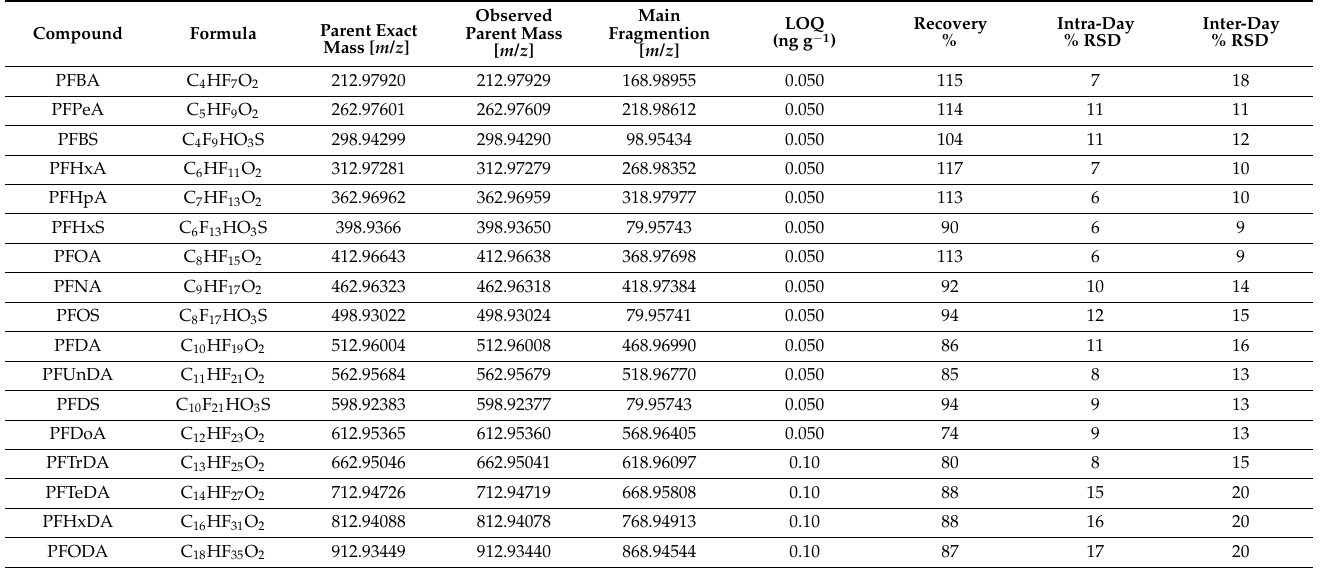
Table 3. PFAS list with their formula, parent exact mass and validation